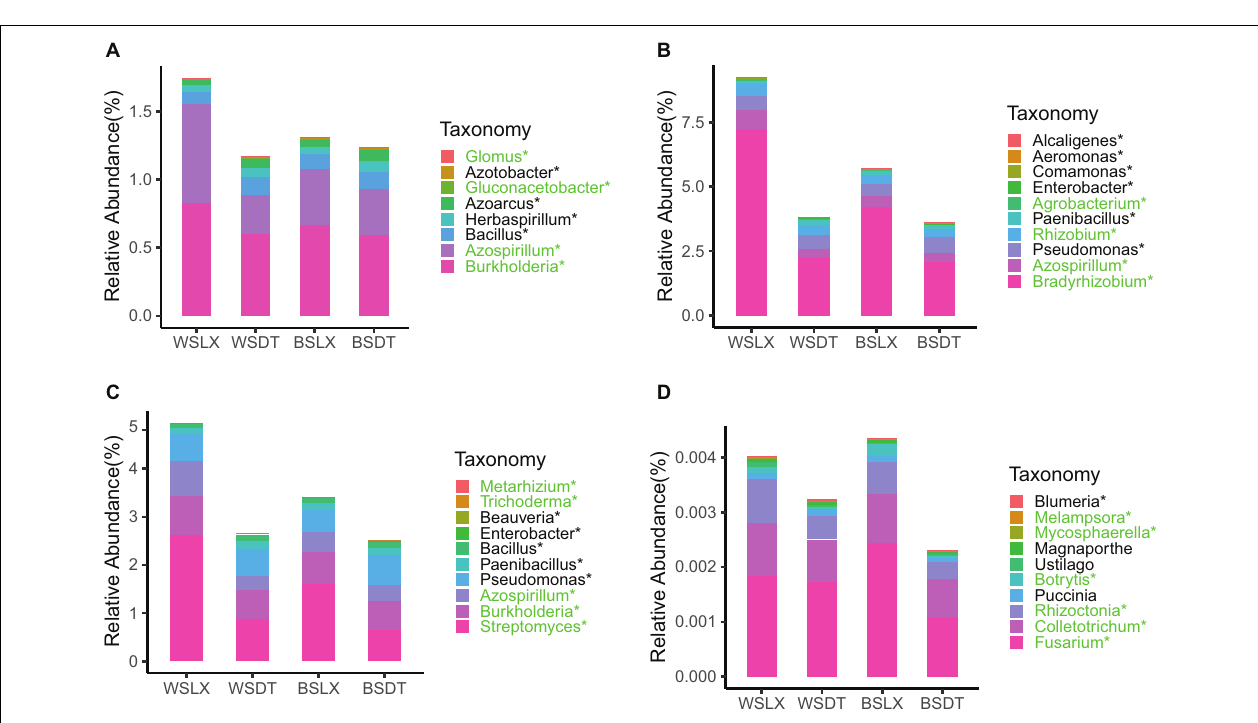
FIGURE 5 | Phyla-level distributions of core rhizosphere microbiomes in cropland planting ( n = 52) and understory planting ( n = 70) patterns based on metagenomic data. (A) Detailed relative abundances of core prokaryotic rhizosphere microbiomes. (B) Detailed relative abundances of core fungal rhizosphere microbiomes. Asterisk indicates a significant difference with P < 0.05 (MW test). WSDT, rhizosphere soil of cropland planting in Wenshan City; WSLX, rhizosphere soil of understory planting in Wenshan City; BSDT, rhizosphere soil of cropland planting in Baise City; BSLX, rhizosphere soil of understory planting in Baise City.